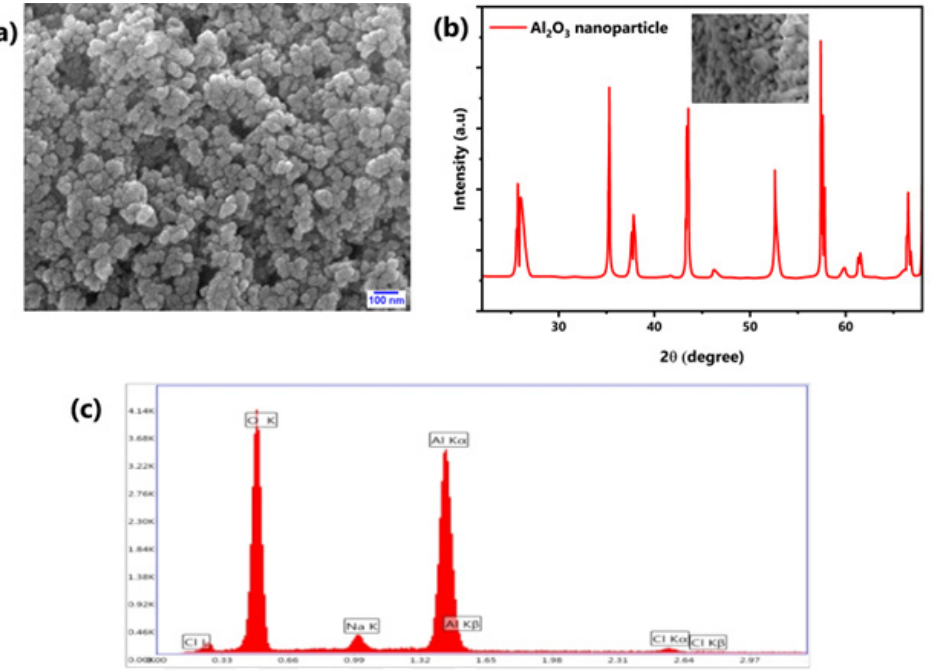
Table 3. Zeta potential analysis of paraffin wax with different compositions of Al 2 O 3 nanoparticles.